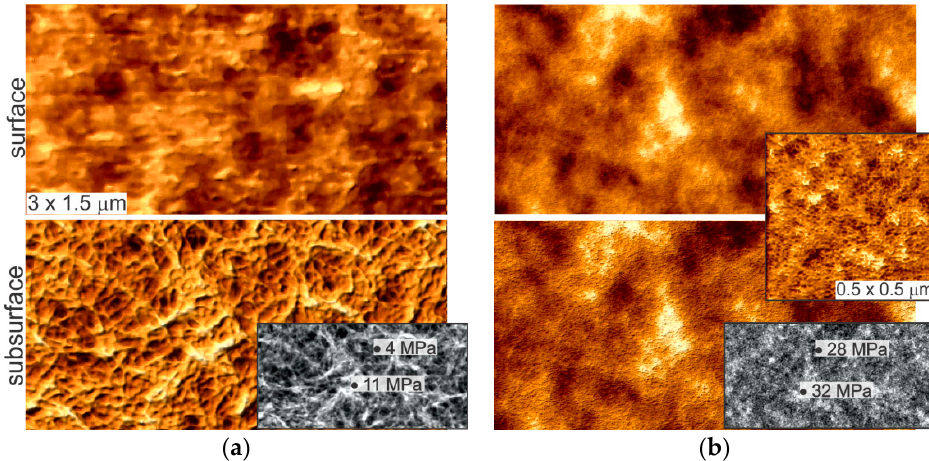
Figure 1. Surface and subsurface of untreated ( a ) and 30 s treated in argon plasma ( b ) polyurethane. The insets show maps of the elastic modulus of the subsurface structure. The lighter areas correspond to the stiff objects. The elastic moduli of the typical soft and stiff areas of the surface are marked.